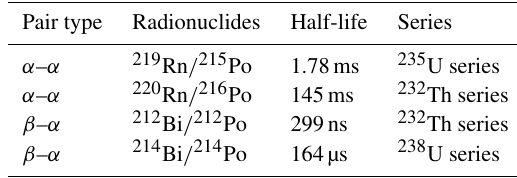
Table 1. Decay pairs used to derive the specific contributions aris- ing from the 238 U, 235 U and 232 Th series as well as from 40